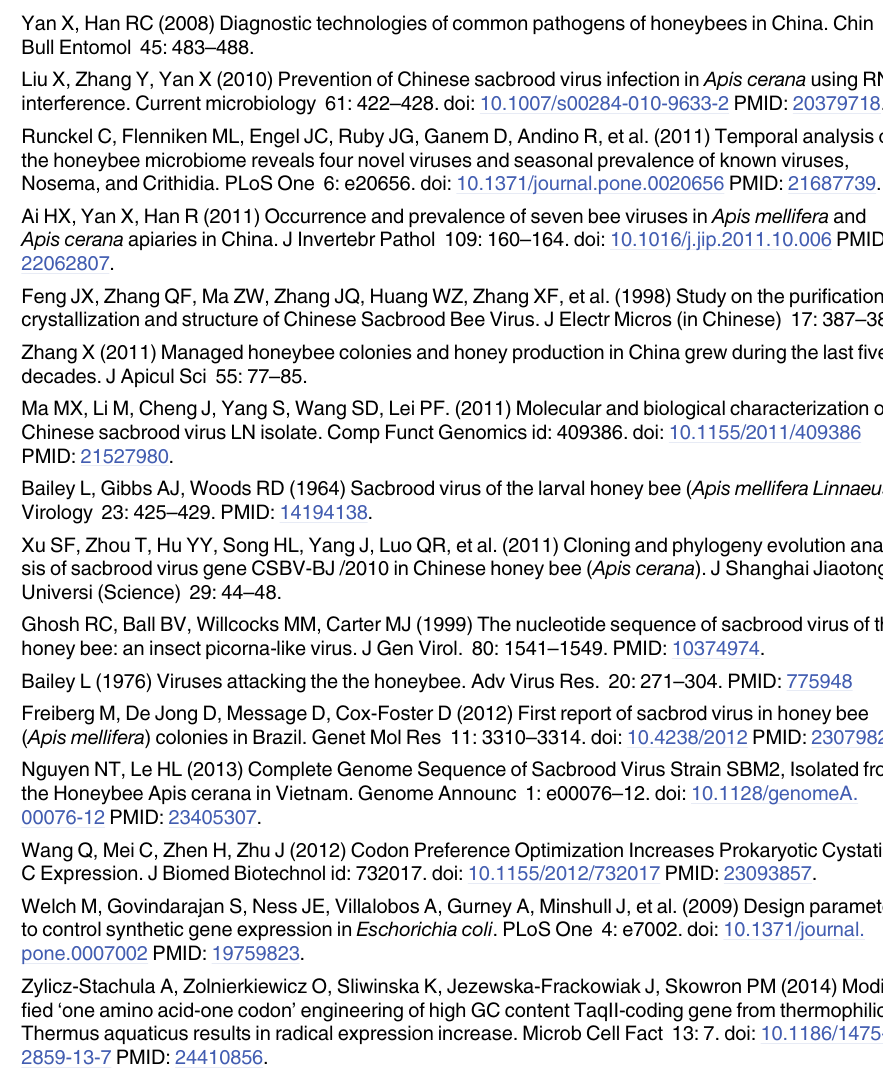
S1 Table. The data of specific IgG antibodies in serum of the immunized mice. S2 Table. The data of SI values in the Lymphocyte